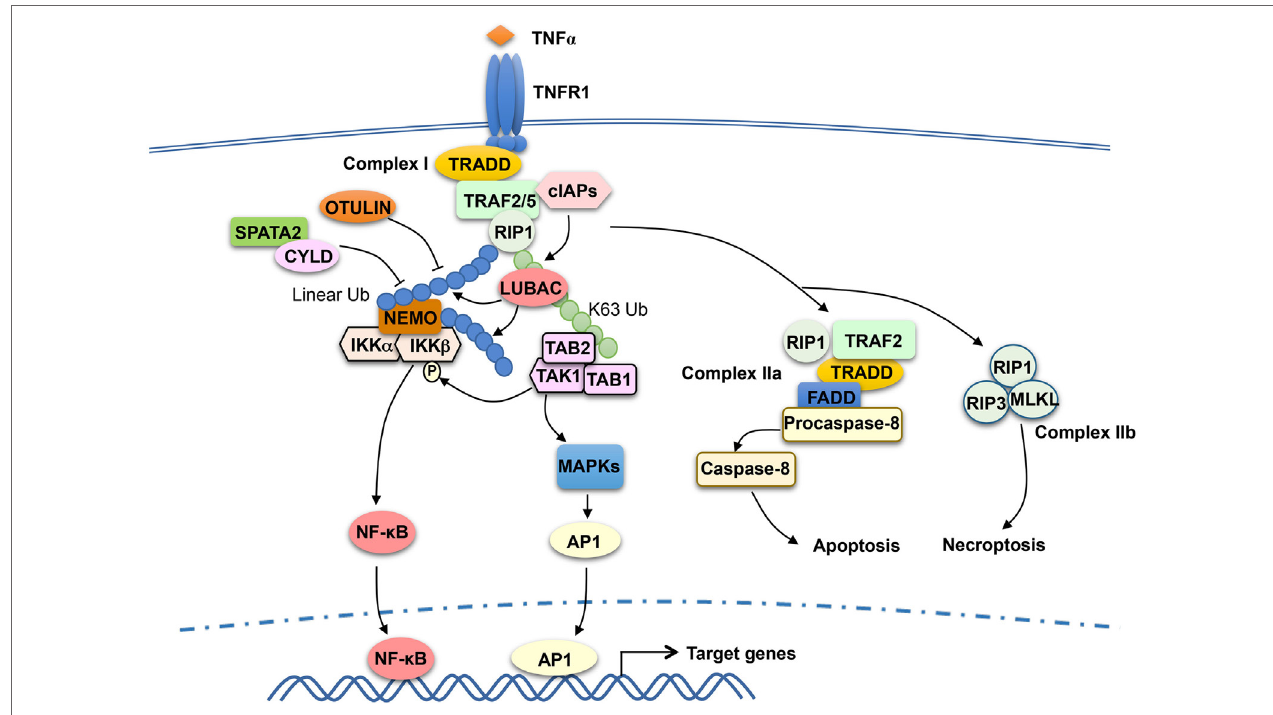
FigURe 2 | Tumor necrosis factor receptor-associated factor (TRAF)2 and TRAF5 in tumor necrosis factor receptor (TNFR)1 signaling. TNF α binding to TNFR1 triggers the assembly of a TNFR1-associated signaling complex, complex I, which is composed of TNF receptor-associated death domain (TRADD), receptor- interacting protein kinase 1 (RIP1), TRAF2 or TRAF5 (TRAF2/5), and the E3 ubiquitin ligases cIAP1 and cIAP2 (cIAPs). Upon activation, cIAPs conjugate K63- linked ubiquitin chains to RIP1, which facilitates recruitment and activation of the kinase transforming growth factor beta-activated kinase 1 (TAK1) as well as the recruitment of the linear ubiquitin ligase complex LUBAC. LUBAC conjugates linear ubiquitin chains to RIP1 and, thereby, facilitates the requirement of I κ B kinase (IKK) via the linear ubiquitin-binding function of NF- κ B essential modulator (NEMO). Subsequent ubiquitination of NEMO by LUBAC, along with TAK1-mediated IKK β phosphorylation, results in IKK activation. The activated IKK and TAK1 mediate activation of nuclear factor κ B (NF- κ B) and mitogen-activated protein kinase (MAPK)/ AP1 signaling pathways that promote cell survival. TRAF2 also participates in the subsequent formation of a cytoplasmic complex, complex IIa, which mediates apoptosis induction. When caspase-8 is inhibited, TNFR1 signaling also leads to formation of complex IIb, leading to necroptosis. DUBs, including OTULIN and CYLD, negatively regulate signaling functions of LUBAC by cleaving linear ubiquitin chains. SPATA2, as a high-affinity binding partner of CYLD and LUBAC, facilitates CYLD function by recruiting CYLD to